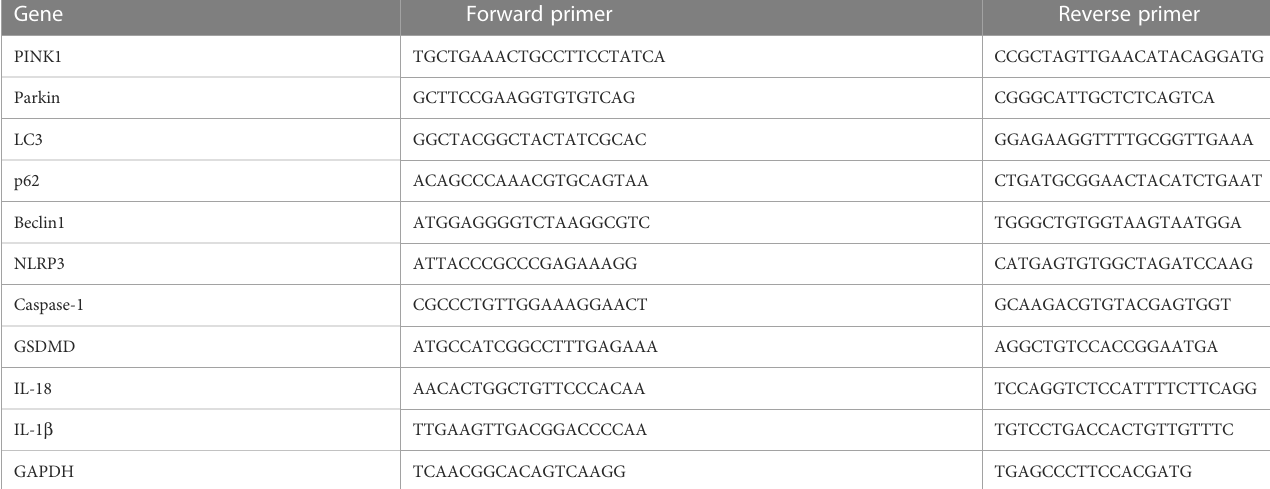
TABLE 2 Primer sequences of the target genes.